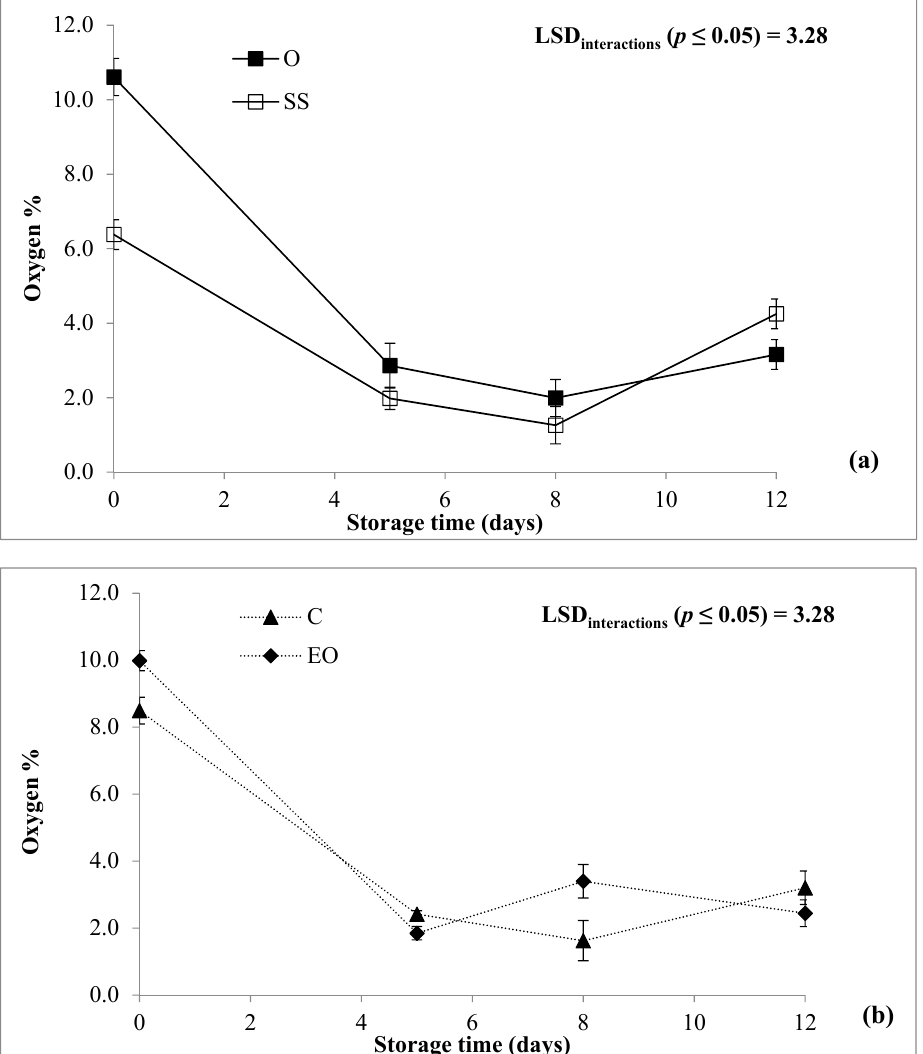
Figure 2. Oxygen (%) of RTC globe artichoke slices as affected by “genotype × storage time” ( a ); “post-harvest treatment × storage time” ( b ); interaction. O: “Opera F1”; SS: “Spinoso sardo”; C: control; essential oil (EO): Samples packed with essential oil of F. vulgare . Data are reported as means ± standard deviation.